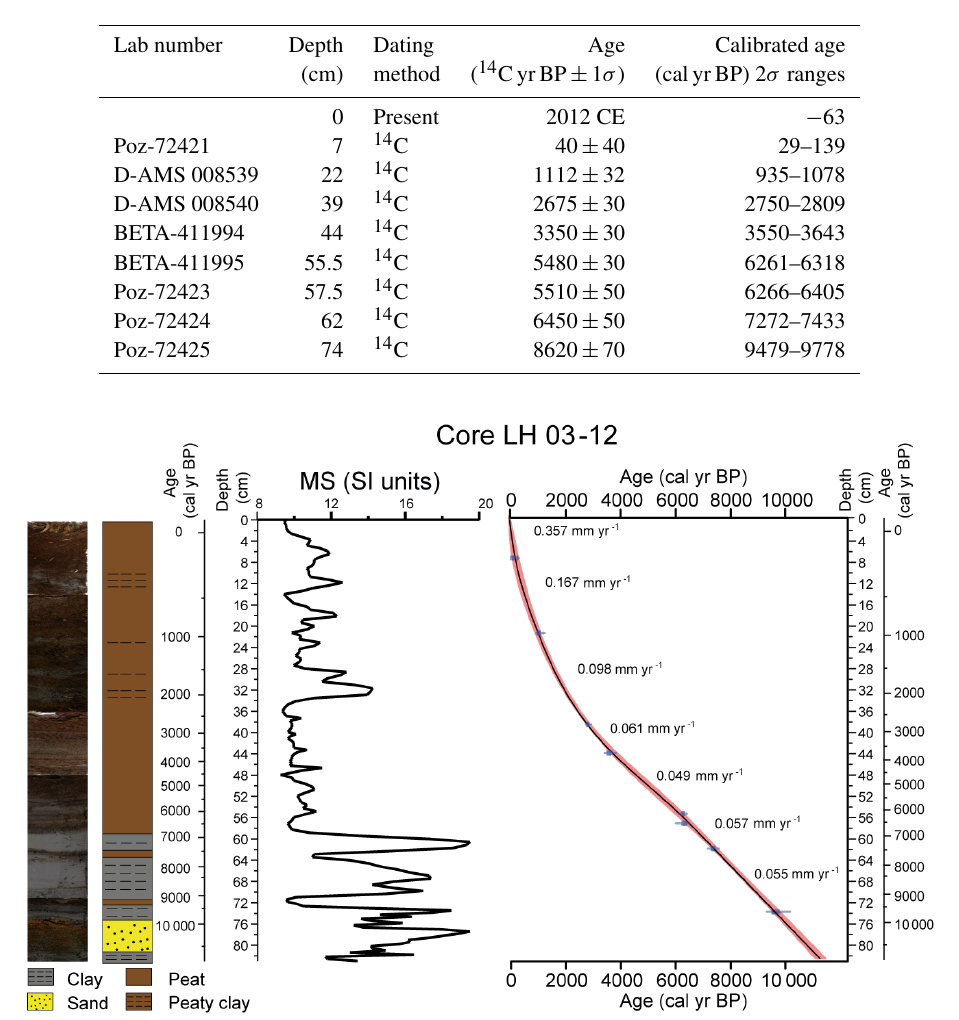
Figure 2. Photo of core LH 12-03, along with the lithology, magnetic susceptibility (MS, in SI units) profile and age–depth model. Sediment accumulation rates (SARs in mmyr − 1 ) are shown between individual radiocarbon ages; the red shadow represents the plus–minus range (see details in text for method of